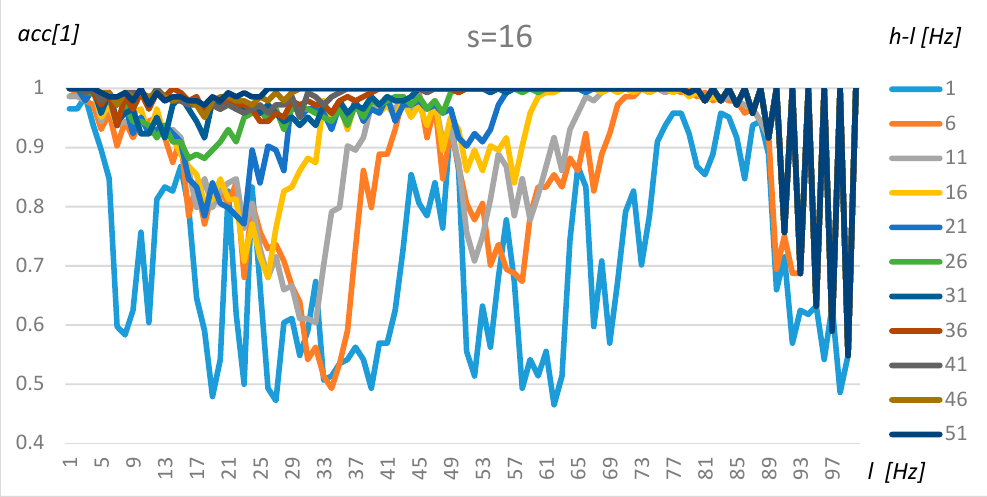
= 16, and various l and h